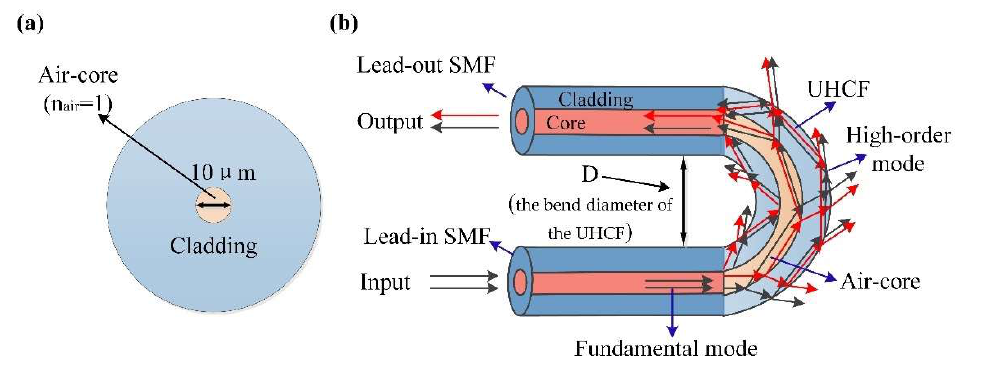
Figure 1. ( a ) Cross-section of the HCF. ( b ) Schematic diagram of the SMF-UHCF-SMF structure with optical path.